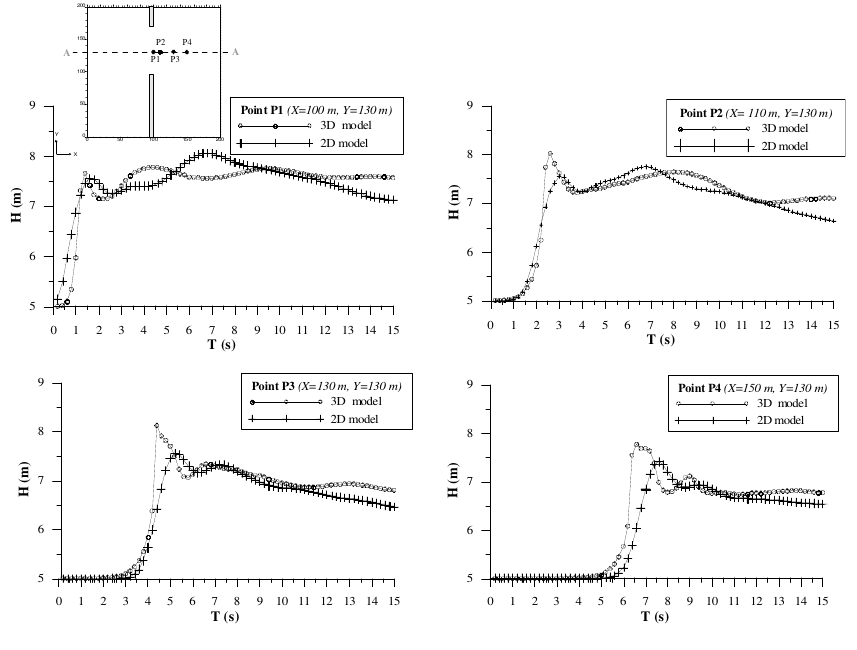
Fig. 5. Water level hydrograph at points P1, P2, P3,